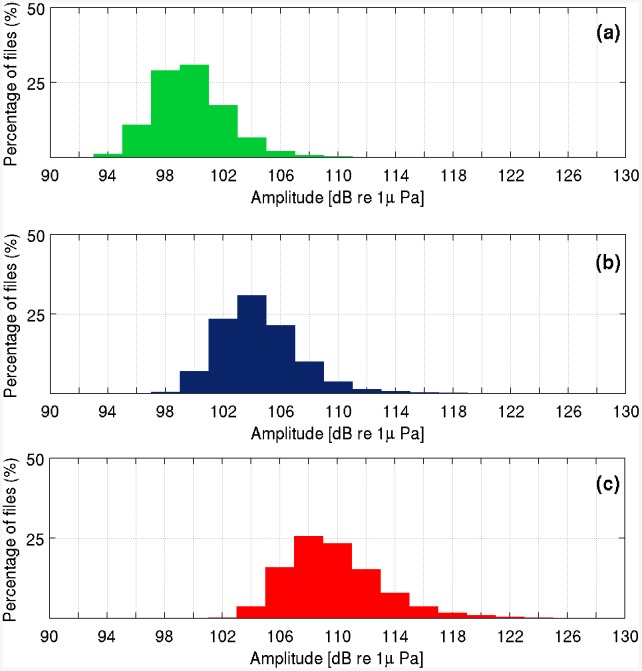
Background noise distribution.Distribution of the 5th (a), the 50th (median) (b), and the 98th (c) percentiles of noise integrated within the 17.9–22.5 Hz frequency band, measured per each 10 minute file (2 dB resolution).